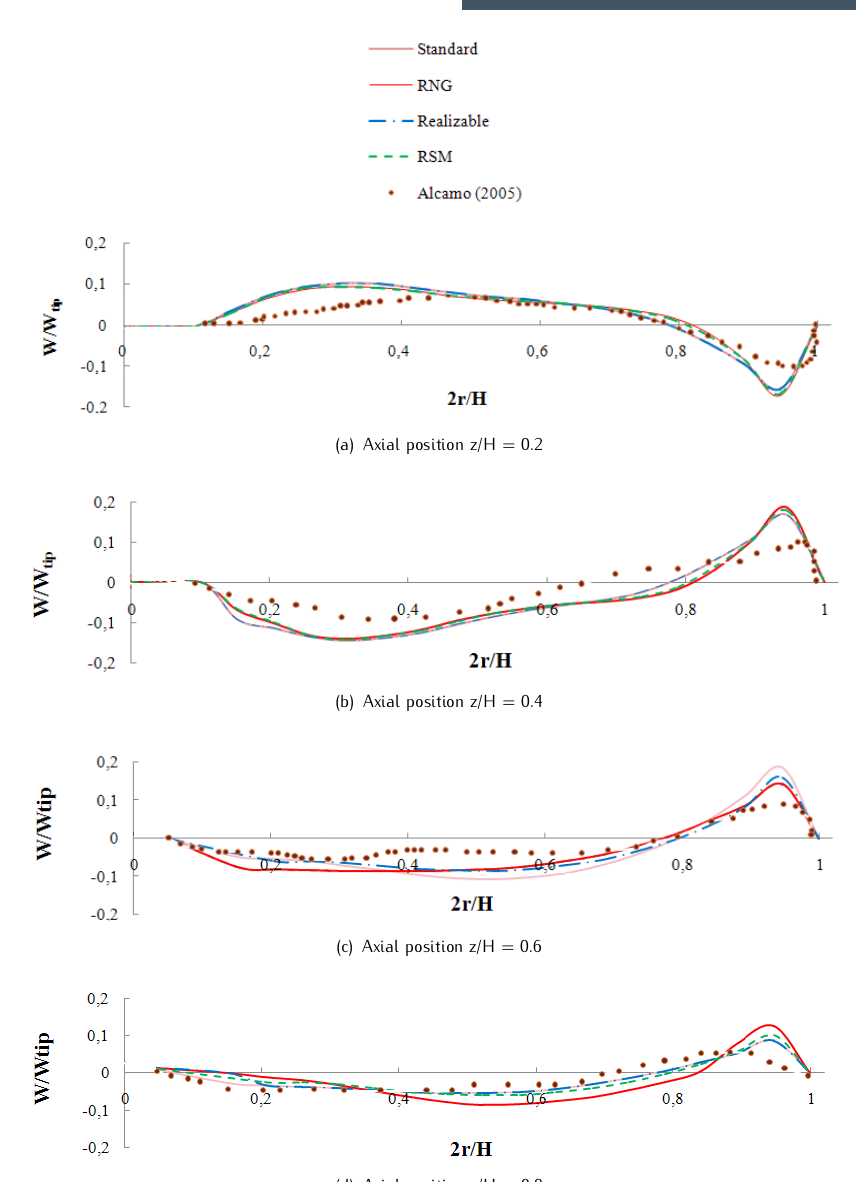
Figure 8. Radial profils of the axial velocity .